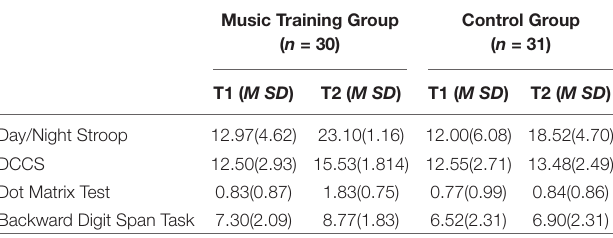
TABLE 5 | The executive function task data of the experimental group and the control group.